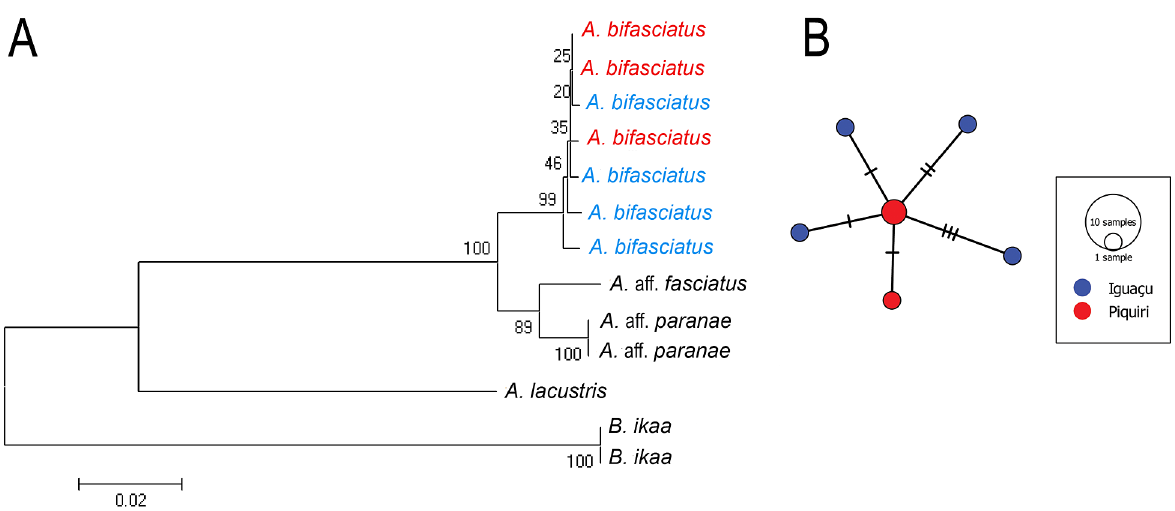
Figure 4. Genetic analyses of Astyanax bifasciatus in streams of lower Iguaçu and Piquiri river basins based on COI gene. A. Neighbor- joining tree of 13 sequences (Table A1) using genetic distances, with the branch lengths equivalent to the number of base substitutions per site. Bootstrap values (1000 replications) are indicated next to the branches. Blue: specimens from Iguaçu River basin. Red: specimens from Piquiri river basin, upper Paraná River basin. B. Haplotype network of A. bifasciatus . Traces in each branch refer to number of muta- tional steps between